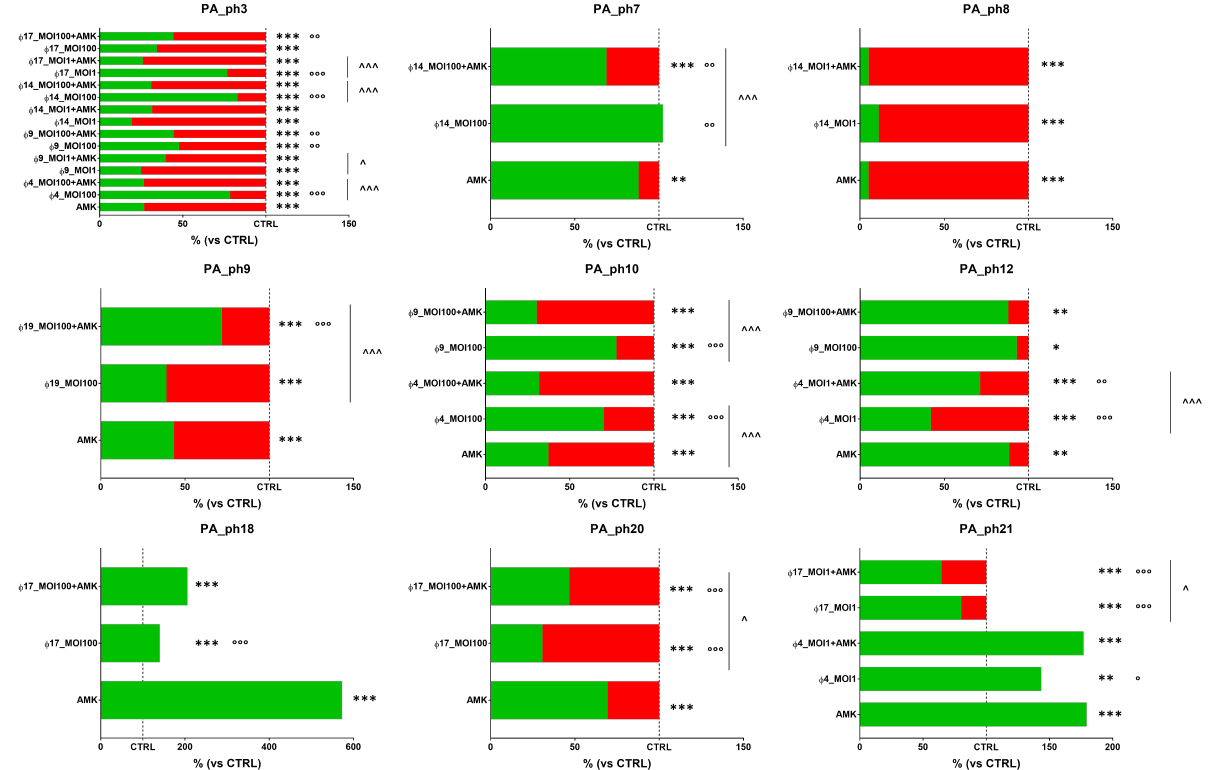
Figure 3. In vitro phage and amikacin (AMK) activity, alone and in combination, against nine 24-h-old cystic fibrosis Pseudomonas aeruginosa (PA) biofilms. Biofilm dispersion evaluated by crystal violet stain. The results are shown as percentages in dispersed PA biofilms (highlighted in red) compared with unexposed PA control samples (CTRL) in trypticase soy broth (TSB); the dotted line indicates 100% residual biofilm after a challenge with TSB; significant levels * p < 0.05, ** p < 0.01, *** p < 0.001 each treatment vs. CTRL; ◦ p < 0.05, ◦◦ p < 0.01, ◦◦◦ p < 0.001 each treatment vs. AMK, and ˆ p < 0.05, ˆˆˆ p < 0.001 each treatment vs. phage-AMK analyzed by the χ 2